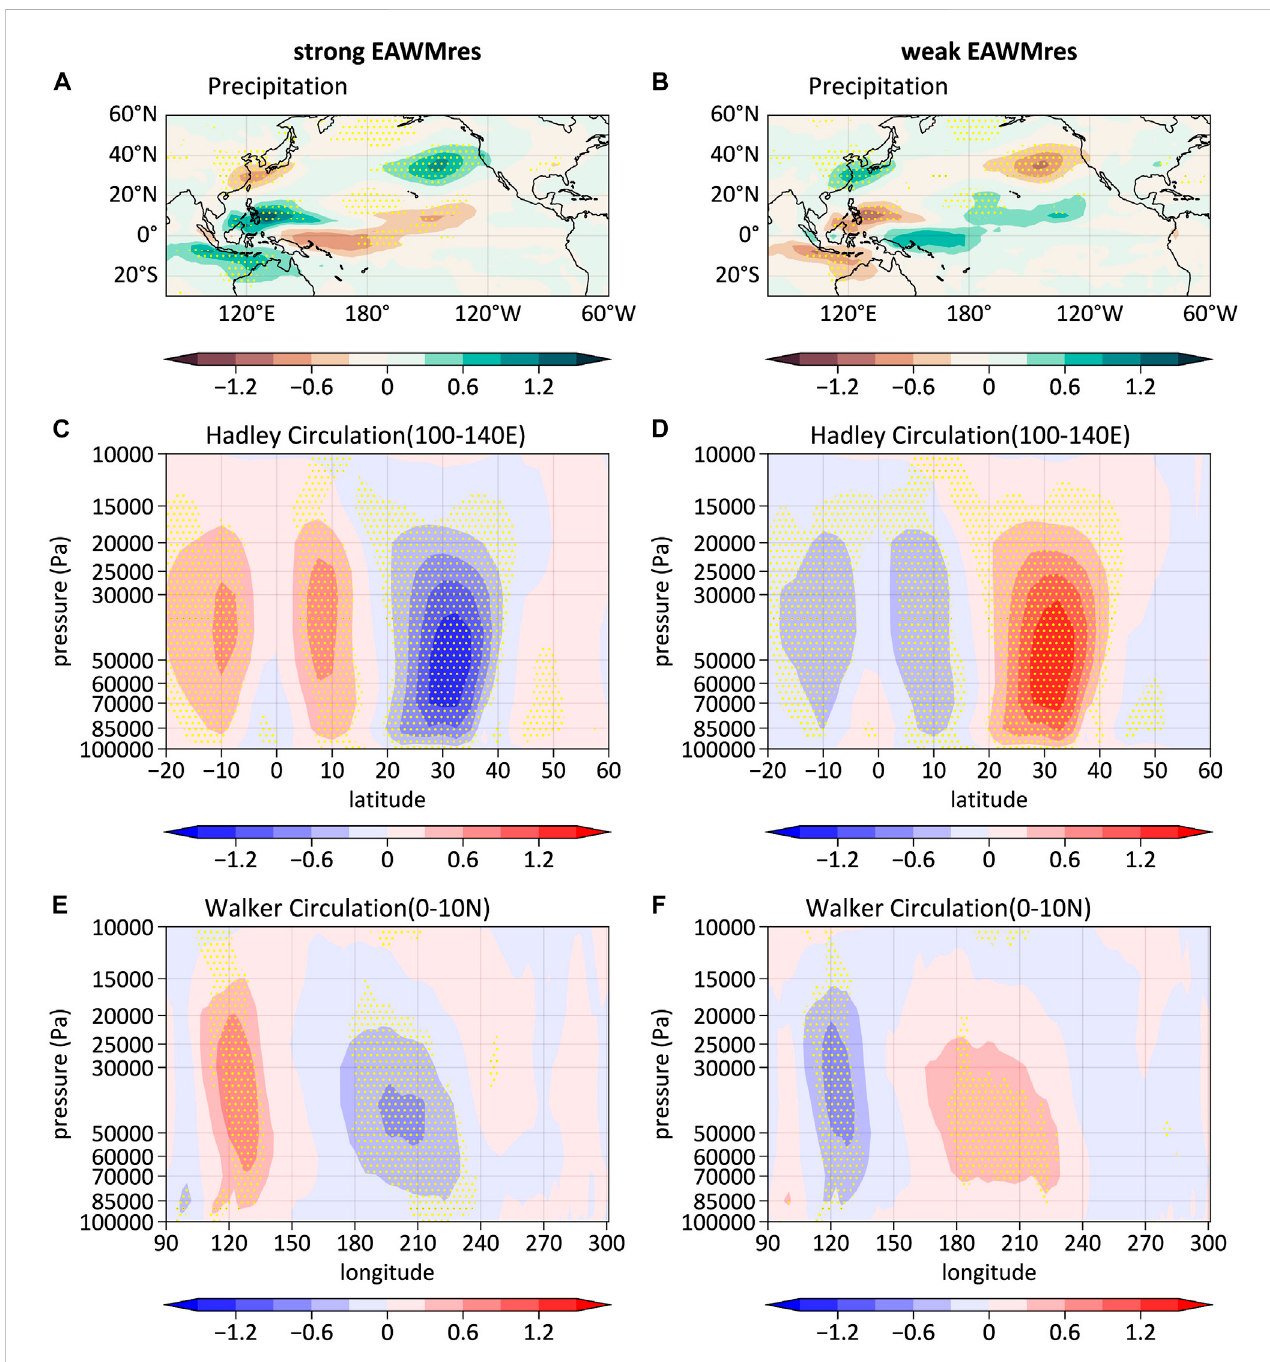
TheMMEof47CMIP6models.Compositeanomalouspatternsof (A,B) precipitation, (C,D) zonalaveragedverticalvelocityalong(100 ° – 140 ° E),and (E,F) meridional averaged vertical velocity along (0 ° – 10 ° N). Left and right columns are for the strong and weak EAWM res winters during 1979 – 2014, respectively. Dotting indicates more than 80% of the models have consistent signs of the anomalies. The models are shown in Table